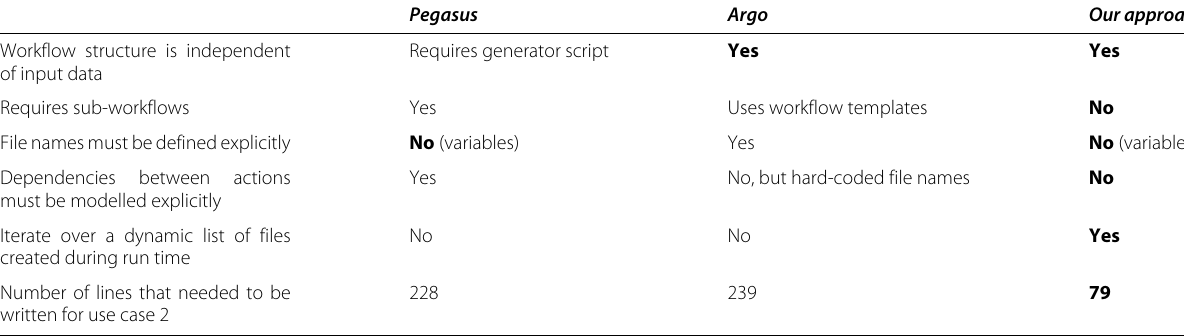
Table 6 Differences between the tested systems with regard to maintainability Pegasus Argo